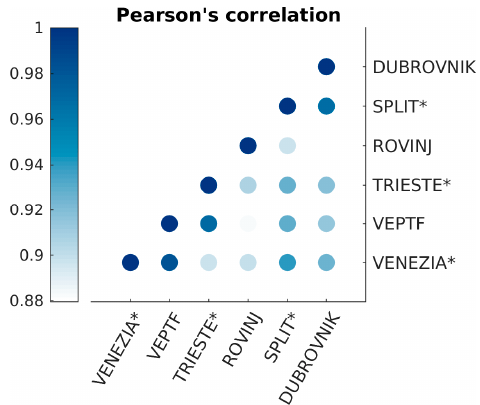
Figure 6. Pearson’s mutual correlation coefficient of six TG time series. Minimum correlation is 0.88 between Rovinj and Dubrovnik. Such high correlation among the six sea level time series indicates that the Adriatic Sea has a consistent response to sea level changes at the sub-secular timescale.